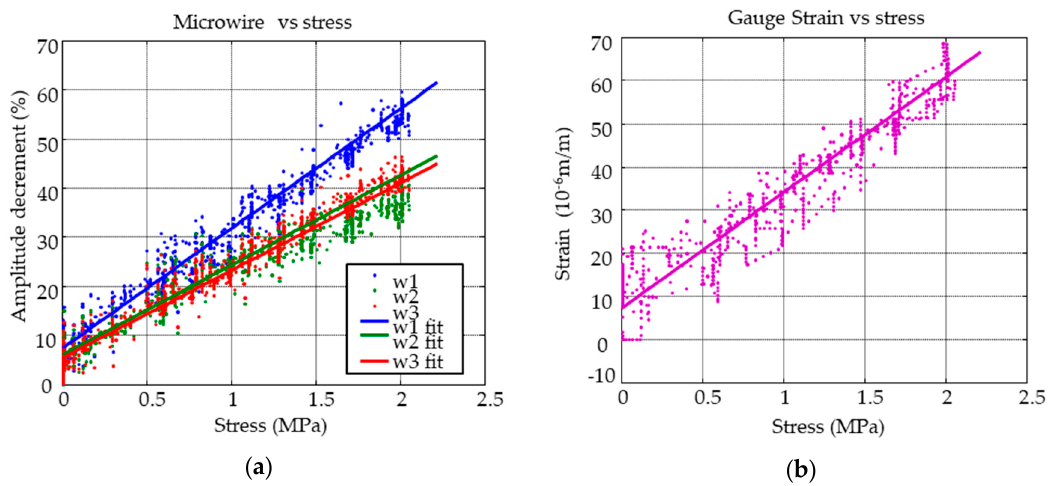
Figure 7. Stress measurements performed during the loading/unloading tests in the concrete specimen using ( a ) MMCC sensors and ( b ) strain gauge.